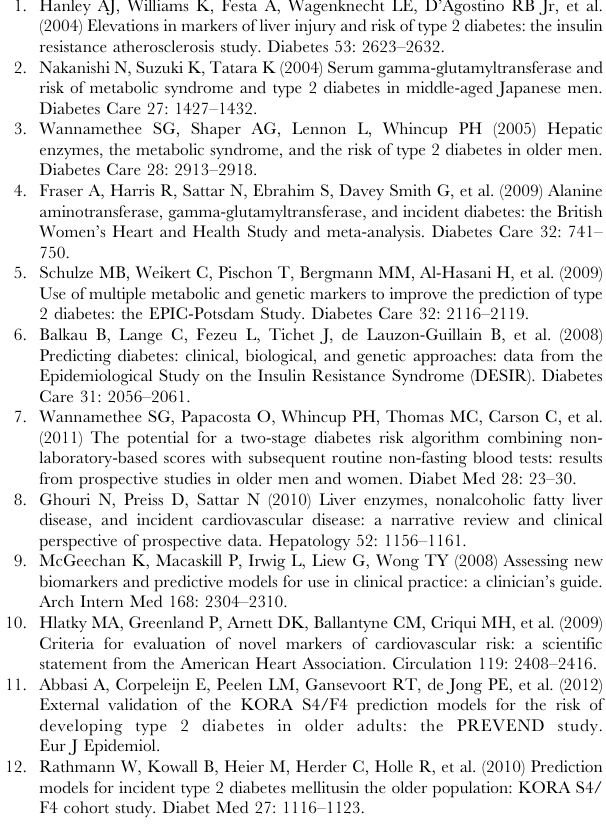
Figure S1 Calibration plots for comparison of the predicted 7.5- year risk of diabetes (according to the KORA basic model) against observed risk of developing type 2 diabetes. Panel A (the EPIC-NL case-cohort study), Panel B (the PREVEND cohort study). The ‘ideal’ and ‘non-parametric’ terms, the dashed line denotes the ideal calibration line (slope= 1, intercept = 0) and the dotted line denotes smooth calibration curve for each models. Hosmer- Lemeshow x 2 statistic were 14.7 (P= 0.10) and 7.8 (P= 0.56) for the calibration performance of KORA basic model (after adjustment for the intercept and the slope) in the EPIC-NL and in the PREVEND studies, respectively. Table S1 Missing data pattern in extrapolated EPIC-NL case- cohort study and PREVEND cohort study. Table S2 Incremental predictive value of components of liver function tests for the risk of future type 2